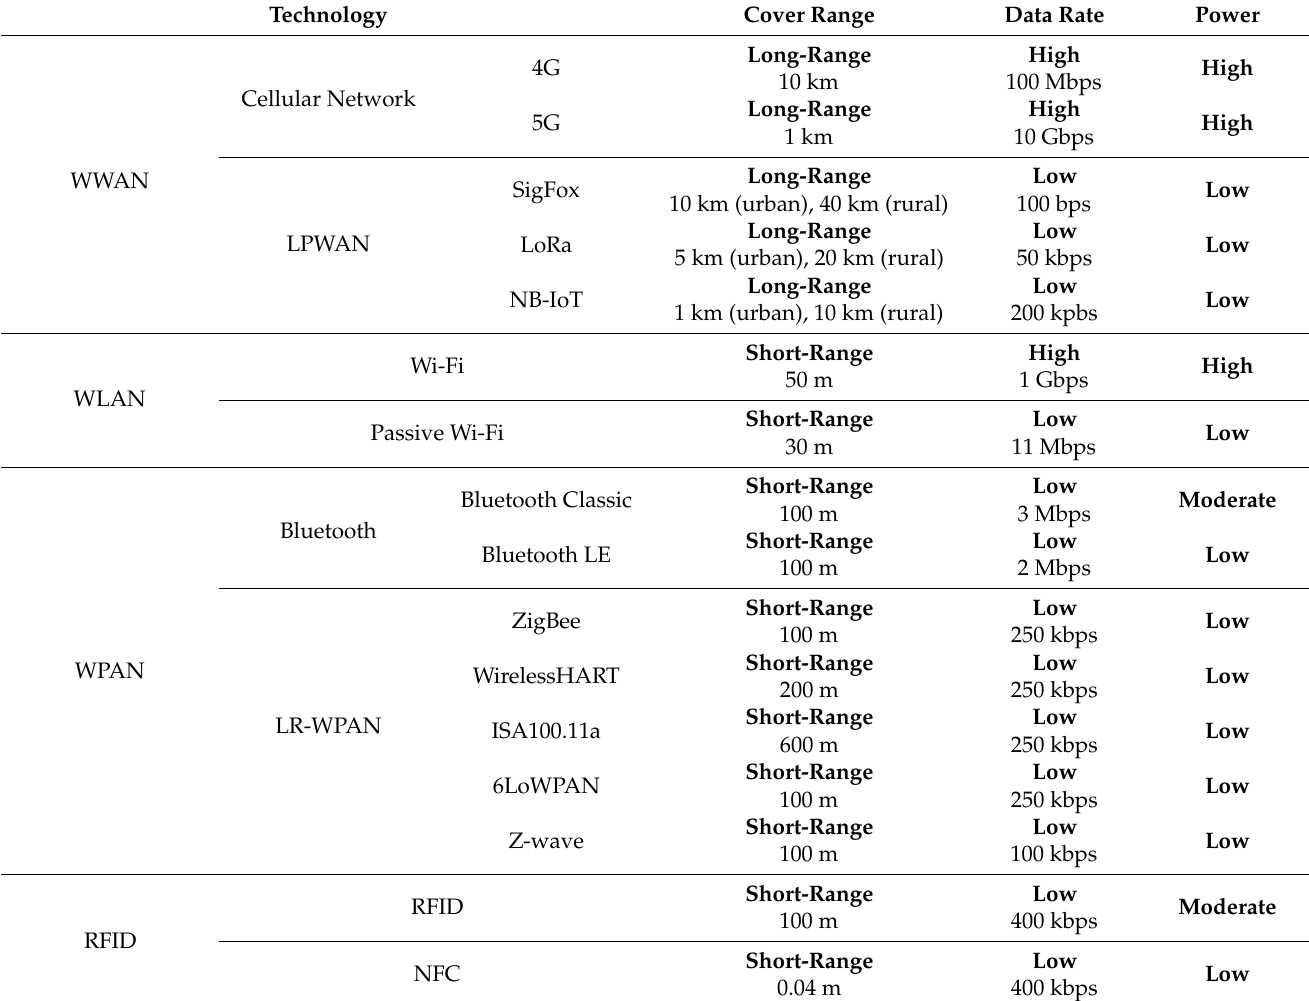
Table 1. Comparison between wireless communication